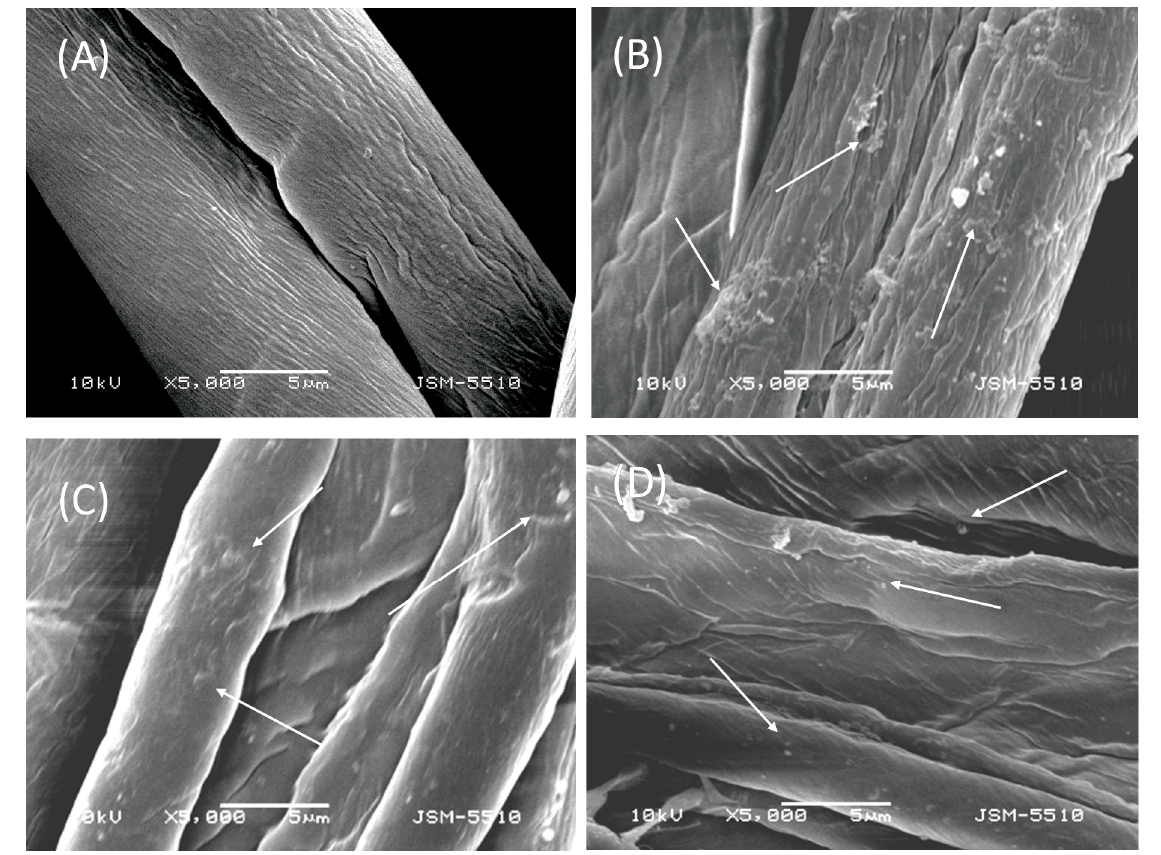
Figure 5. SEM micrographs of the cotton fabric: virgin sample ( A ) and after its treatment with dendrimer D ( B ), [Cu 8 (D)(NO 3 ) 16 ] ( C ), and with copper nanoparticles ( D ).